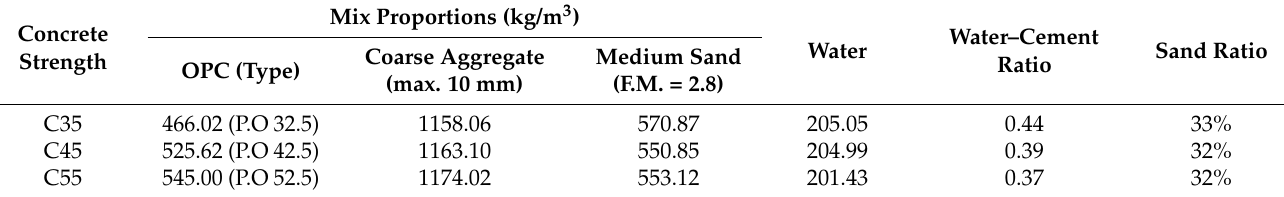
Table 3. Mixture proportions of normal concrete substrate.